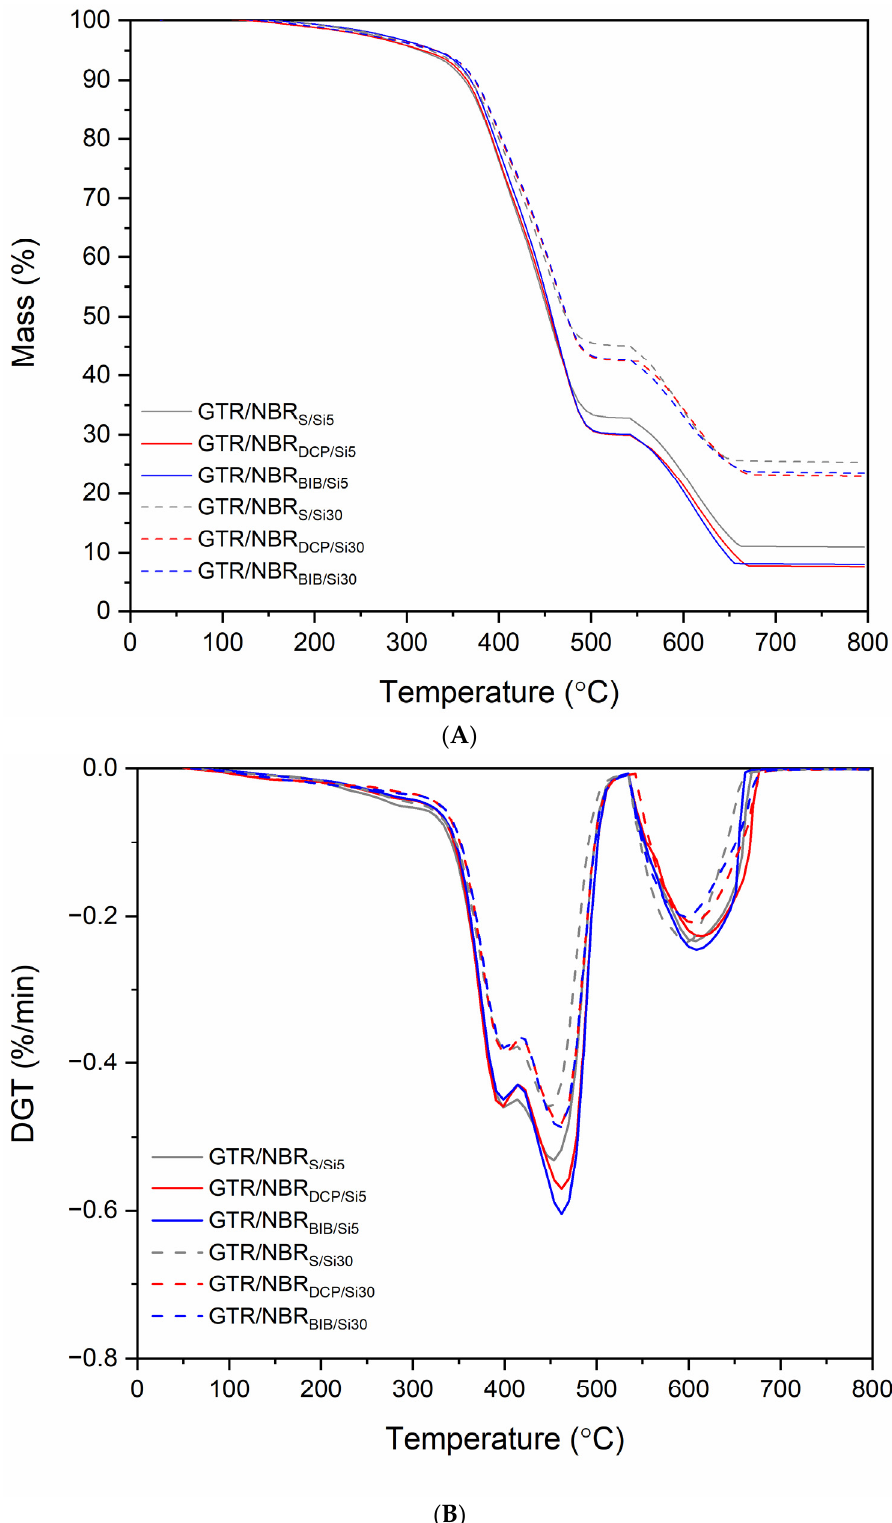
Figure 7. ( A ) TGA curves and ( B ) DTG results for GTR/NBR samples filled with 5 and 30 phr of silica.